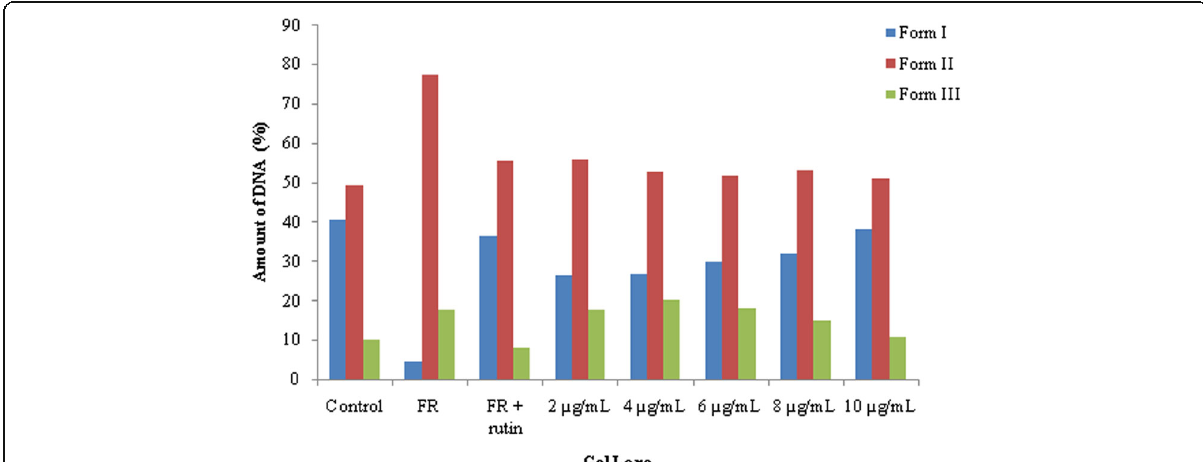
Fig. 4 Densitometric analysis of DNA protective effects of TES17 extract in the presence of hydroxyl radicals generated in DNA nicking assay. Form I- supercoiled DNA, Form II- single stranded nicked DNA, Form III- double standed nicked and linear DNA